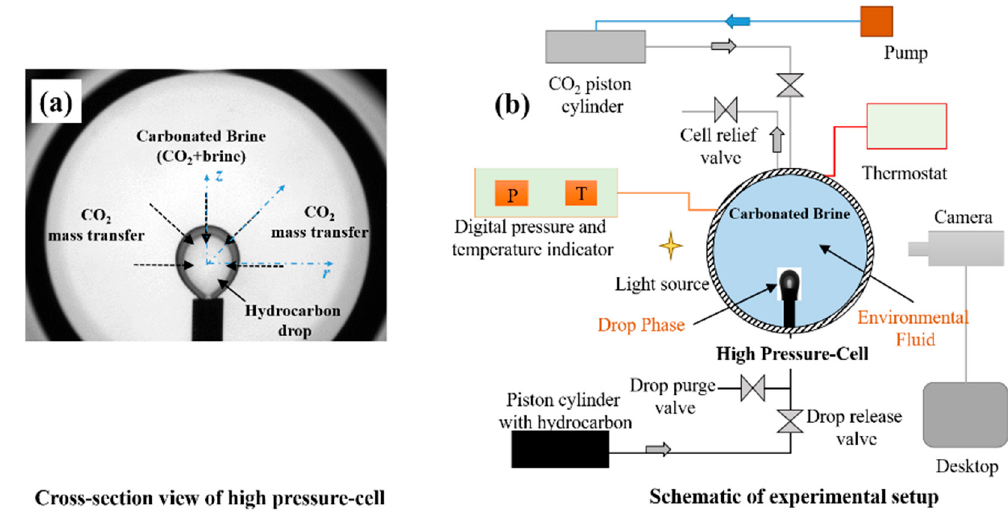
Figure 2. ( a ) Cross-section view of the PVT cell; ( b ) Schematics of the experimental